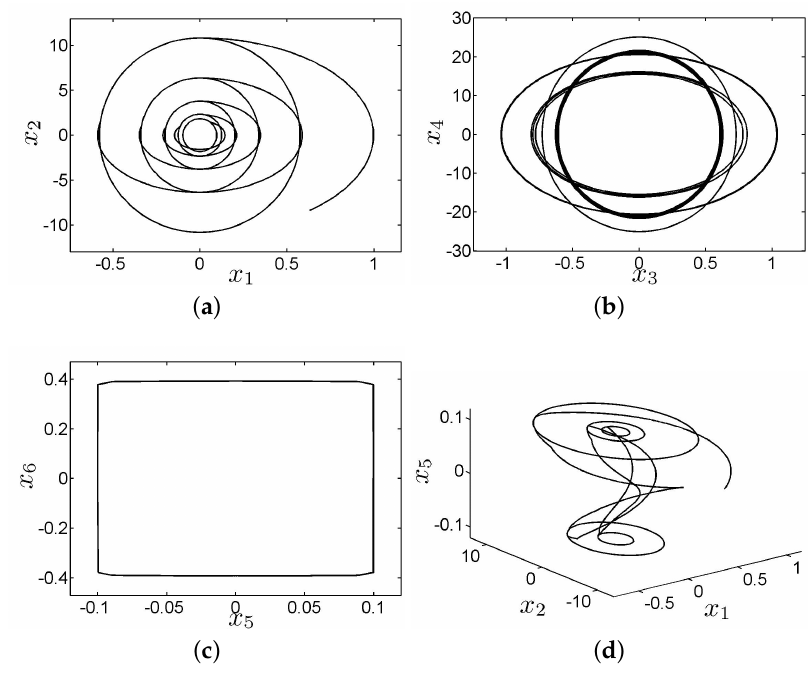
Figure 5. System response in three directions ( ω = 0.06). ( a ) The axial phase diagram. ( b ) The torsional phase diagram. ( c ) The lateral phase diagram. ( d ) Phase diagram in three directions.